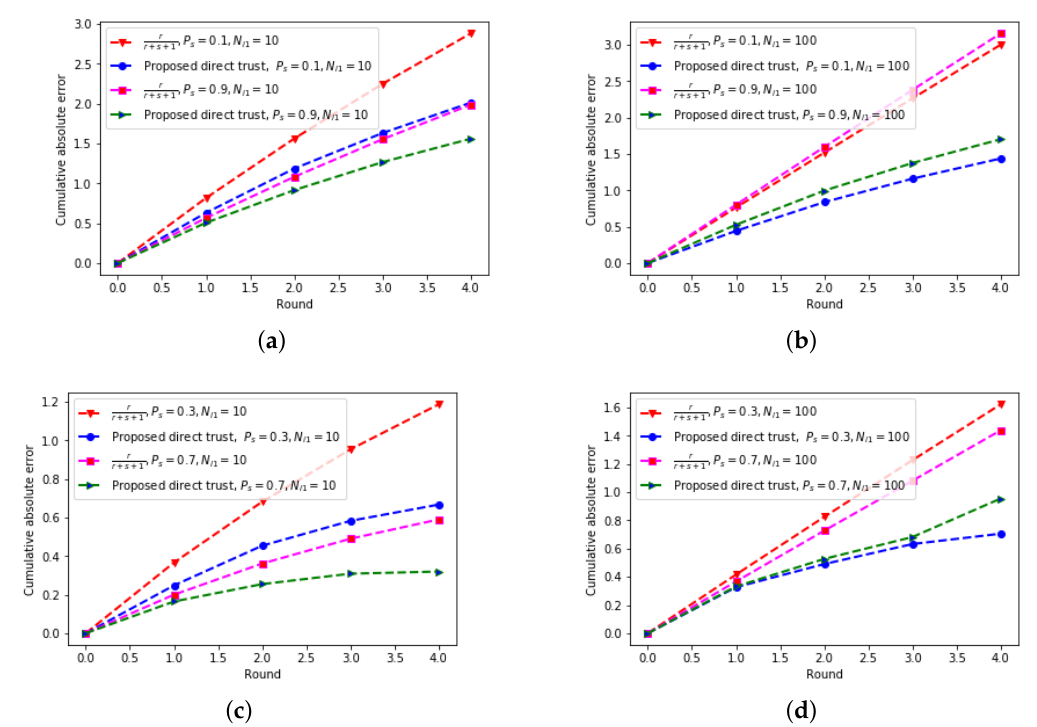
Figure 5. The recent five-round cumulative absolute error, obtained in different interactive rounds of changing performance, under different probabilities: ( a ): 10 rounds and the probability equals 0.1 or 0.9; ( b ): 100 rounds and the probability equals 0.1 or 0.9; ( c ): 10 rounds and the probability equals 0.3 or 0.7; ( d ): 100 rounds and the probability equals 0.3 or